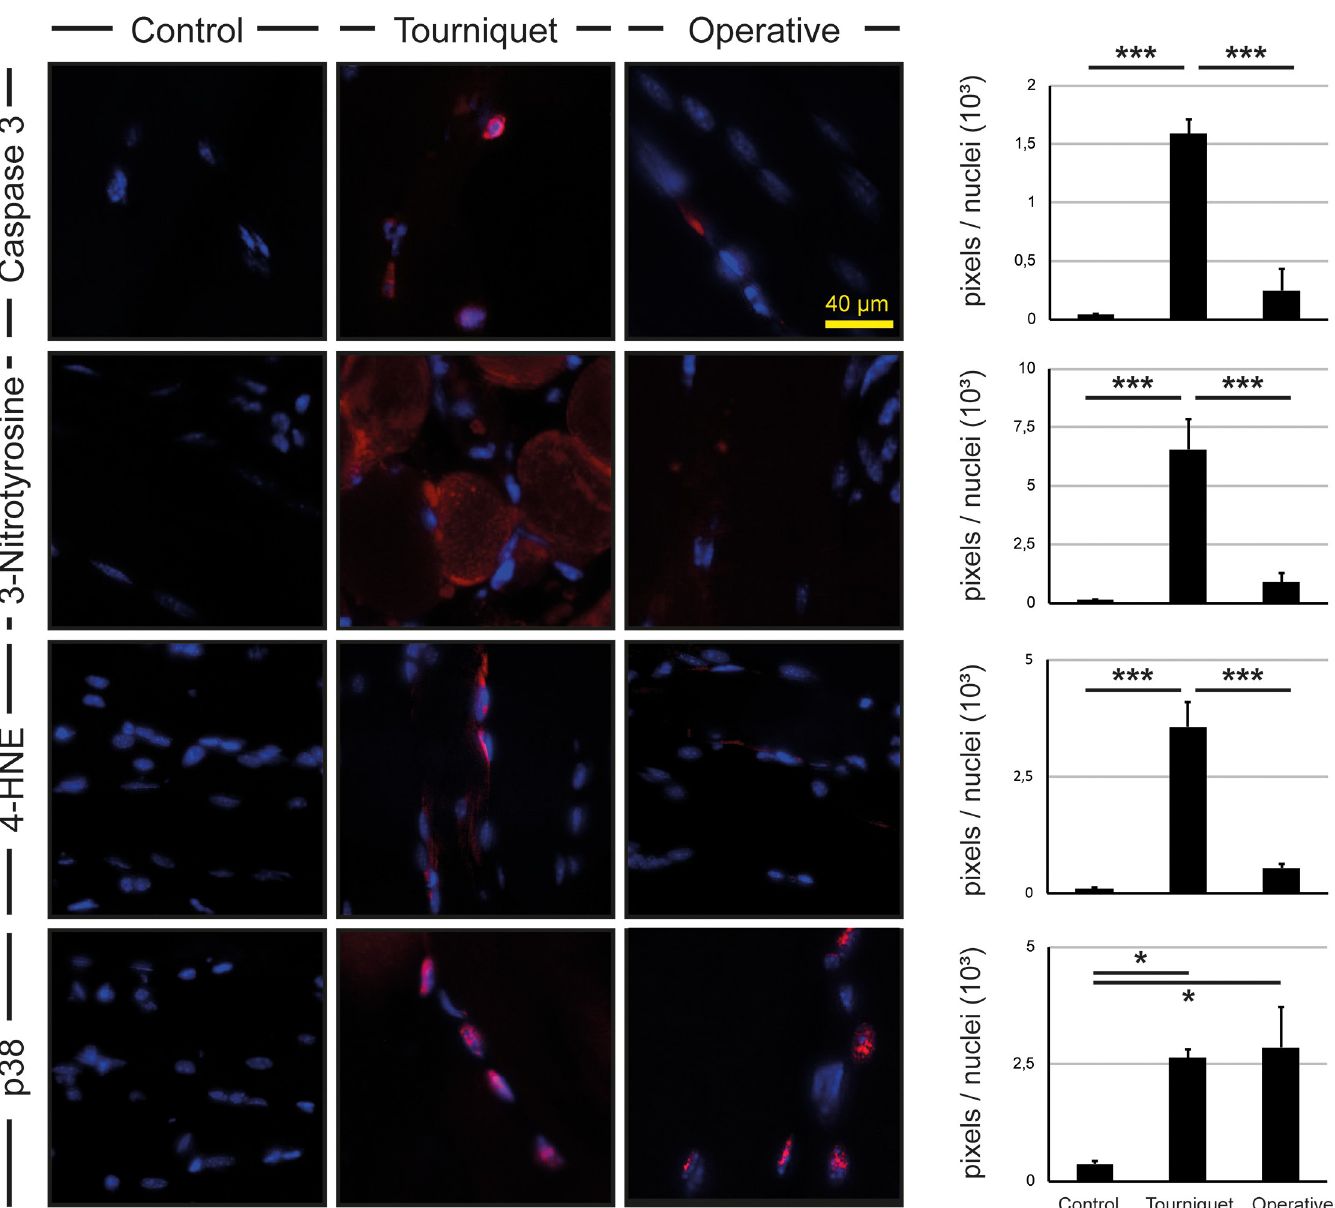
Fig 6. Immunofluorescence of gastrocnemius muscle in tourniquet cohort and operative clamping group. Stainings of Caspase-3, 3-Nitrotyrosine and 4-Hydroxynonenal showed an enhanced signal (red) in mice which underwent the low-pressure tourniquet method compared to control and operative clamping. Levels of p38 were elevated in both the tourniquet and the operative clamping group. Illustrations show regions of 1000 × 1000 pixels each. Results are shown as means ± SEM. Scale bar: 40 μ m. P-value: � < 0.05; ��� < 0.001; (ANOVA), n = 4.